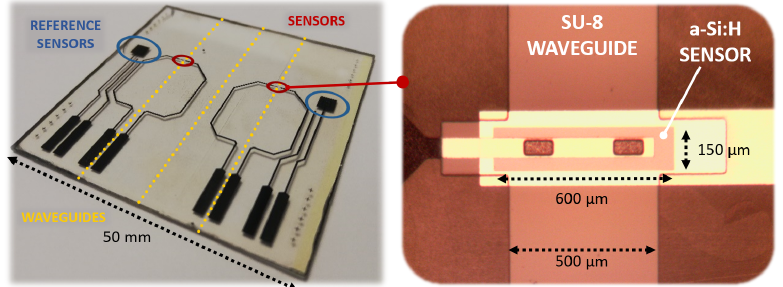
Figure 5. Fabricated prototype ( left side) with an enlargement on the photodiode with the overlapped SU-8 waveguide ( right